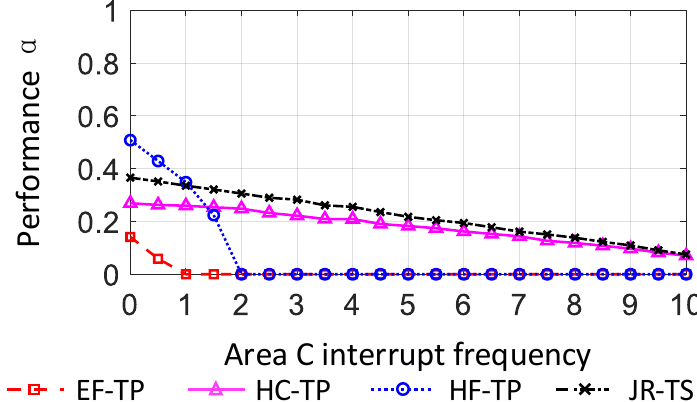
Figure 16. Normalized performance coefficient with manually set